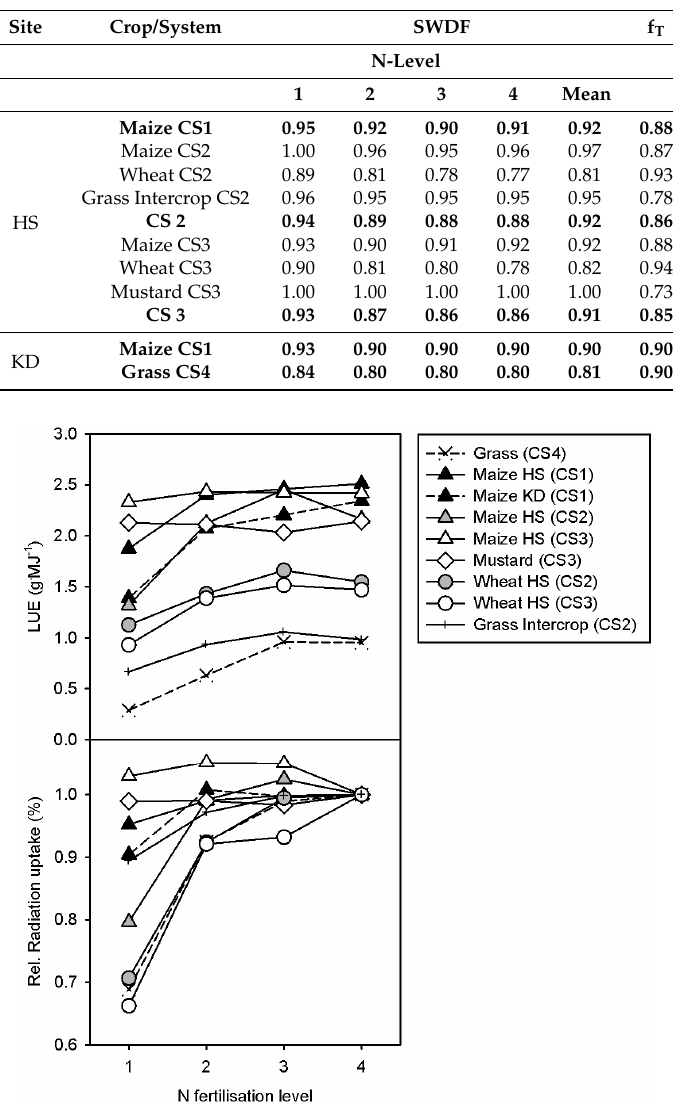
Table 6. Calculated drought stress factor (SWDF) and temperature stress factor f T of all crops and cropping systems in Hohenschulen (HS) and Karkendamm (KD), separated between cropping systems (CS) and N-levels. Only SWDF is given separately for the different N-Levels because f T was not influenced by N supply. f T and SWDF were, before averaging, weighted by the daily PAR absorption. High values indicate low stress impact. Means of a crop rotation is given in bold.